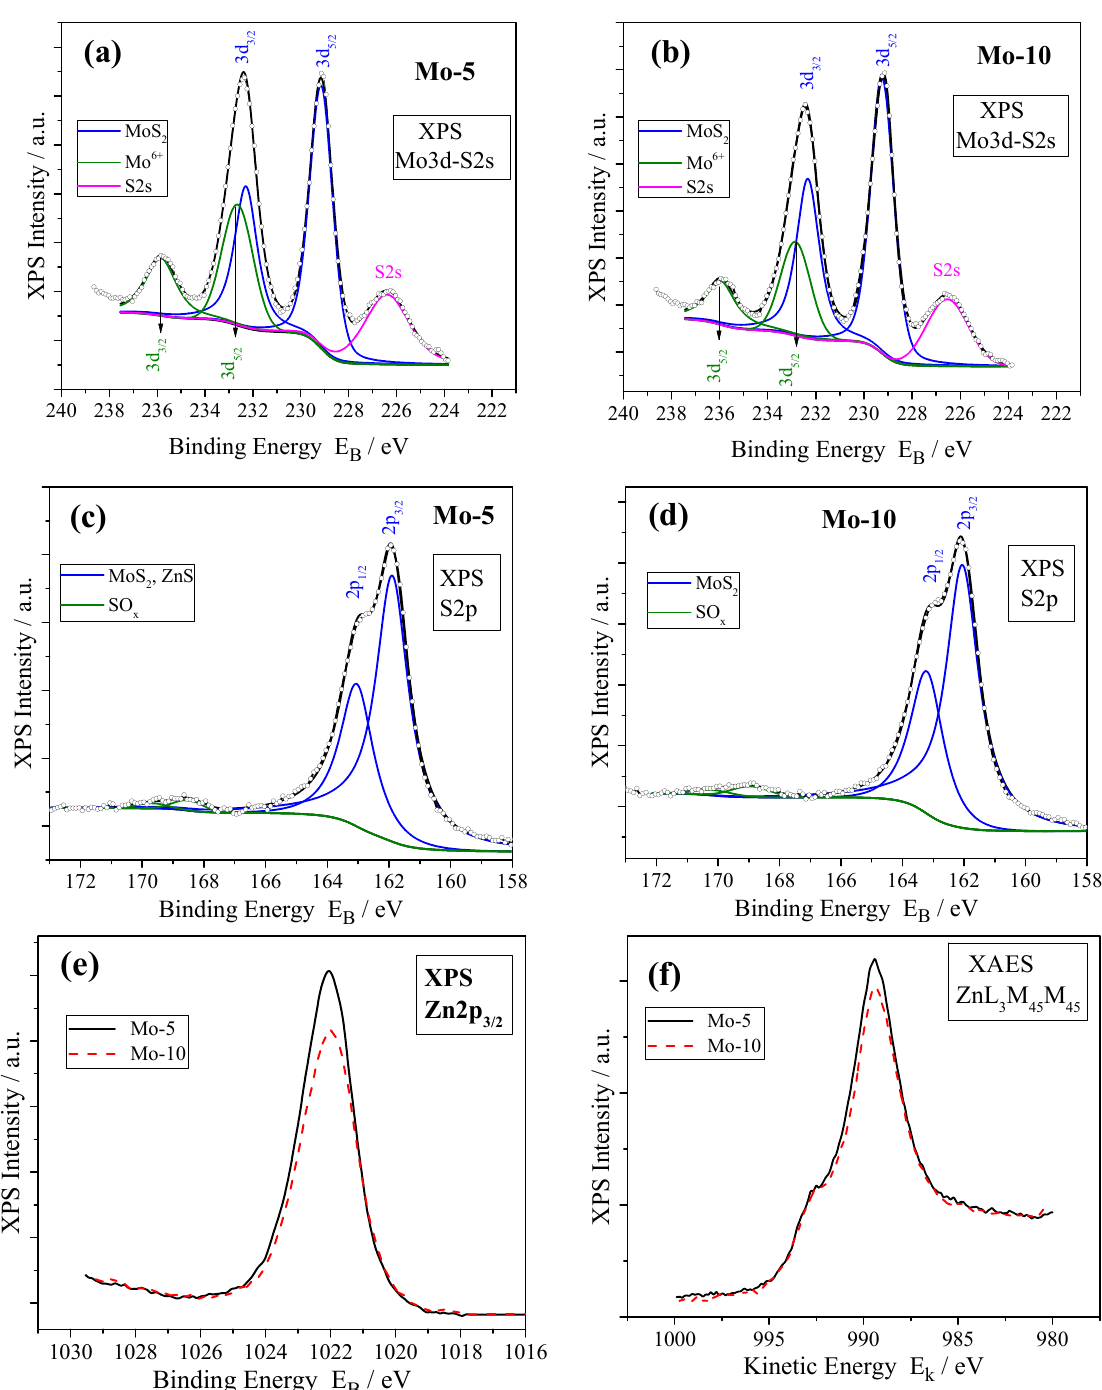
Figure 3. ( a , b ) Deconvoluted Mo3d XPS peak of Mo-5 and Mo-10 heterostructures. ( c , d ) Deconvoluted S2p XPS peak of Mo-5 and Mo-10 heterostructures. ( e , f ) Zn2p 3/2 spectra and ZnLMM XAES spectra of Mo-5 and Mo-10 heterostructures.